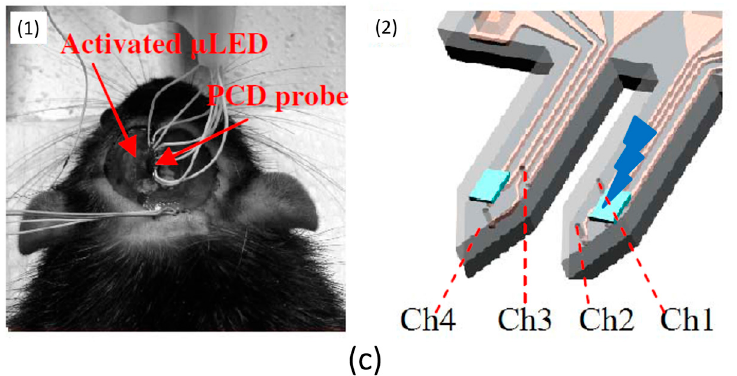
Figure 3. ( a ) Flexible polyimide-based µLED optrode in [45]. (1) A printed circuit board (PCB) is fabricated to assemble the optrode. (2) A scanning electron microscope (SEM) image of the optrode tip. The µLED site is bonded along with three recording sites. (3) A polymerised lens is covered on the µLED. (4) The overall system. µLED is turned on by a 2.9 V forward bias voltage. This figure is reprinted with permission from ref. [45]. ( b ) Samsung µLED mounted at the tip of the fabricated optrode in [46]. Several SU-8 anchors are created along the probe shaft, enhancing the bonding strength of two SU-8 layers. Cooper wire is bonded on the probe via the low melting point (LMP). Epoxy is adopted to further strengthen the bonding robustness. This figure is reprinted with permission from ref. [46]. ( c ) The PCD-based optical probe in [47,48]. (1) This PCD probe is inserted into an experimental rat for the in-vivo test. (2) A diagram of this two-shank probe. In each shank, the µLED is placed at the shaft tip, and two recording channels are positioned in the vicinity of stimulation site. This figure is reprinted with permission from ref. [48].